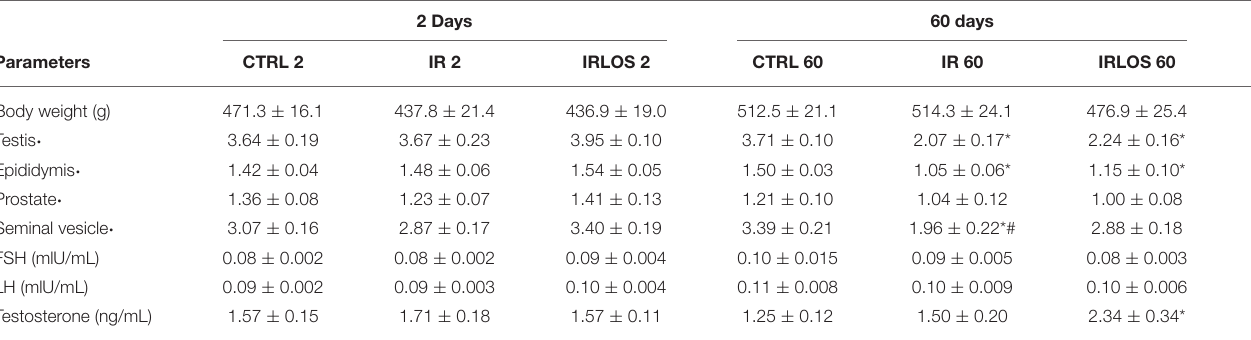
TABLE 1 | Average values of the animal’s weight, reproductive organs wet weight, and FSH, LH and testosterone levels measured in experimental groups after 2- and 60-days of the exposure to irradiation. 2 Days 60